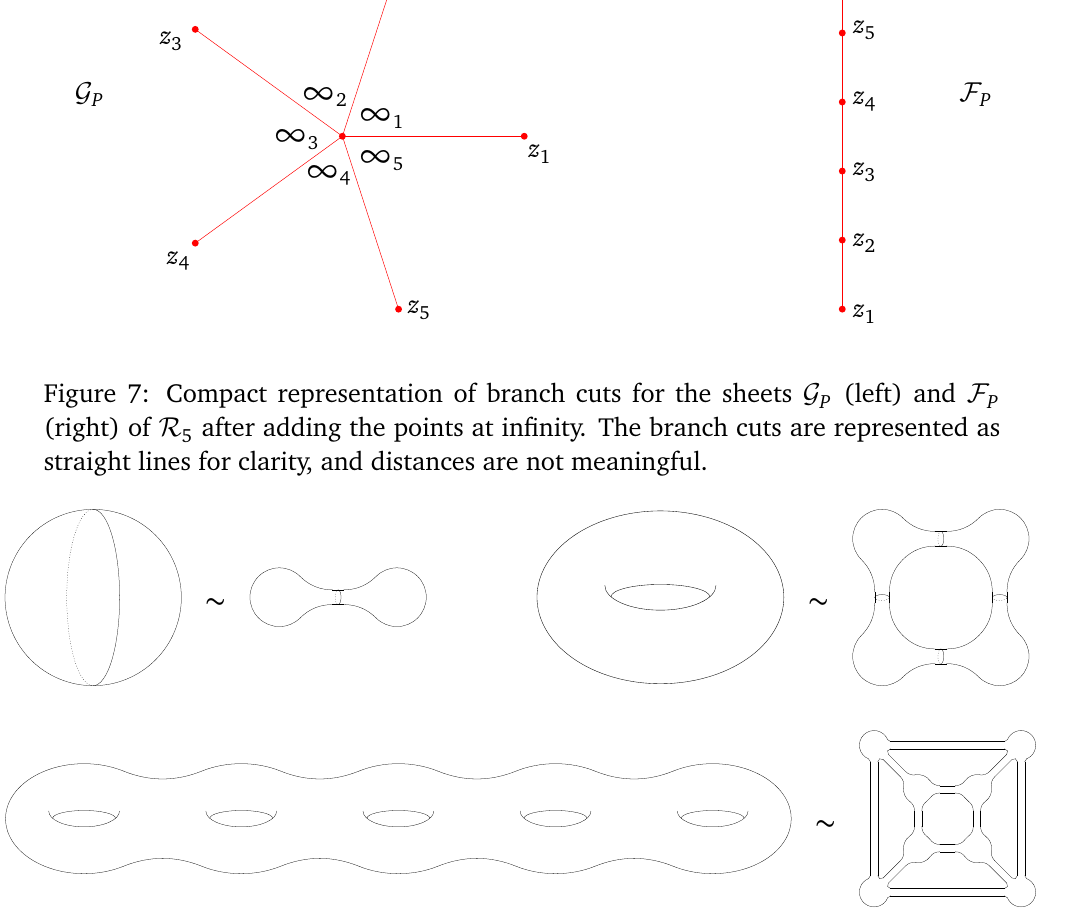
Figure 8: Sphere, torus, and surface with genus g = 5, along with hypercubes of dimensions 1, 2, 3 made of spheres connected with cylinders that can be mapped to them by continuous